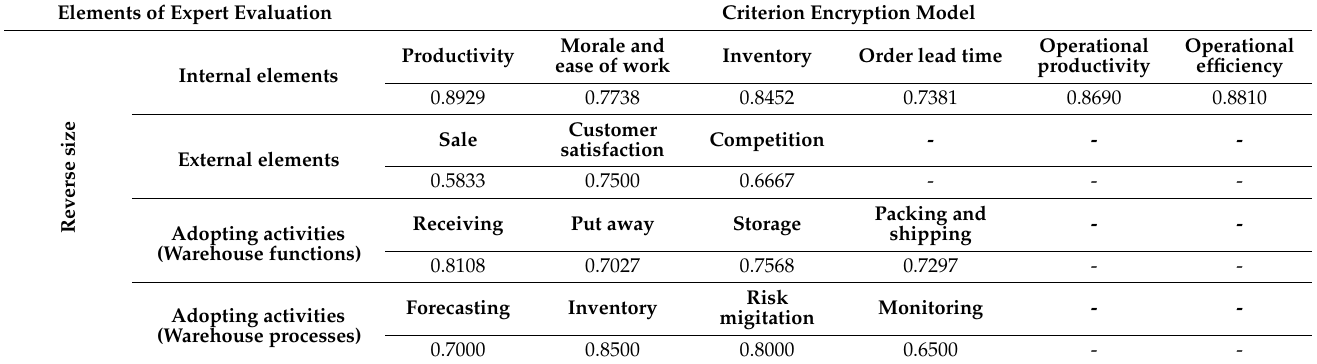
Table 13. The results of the reverse size.